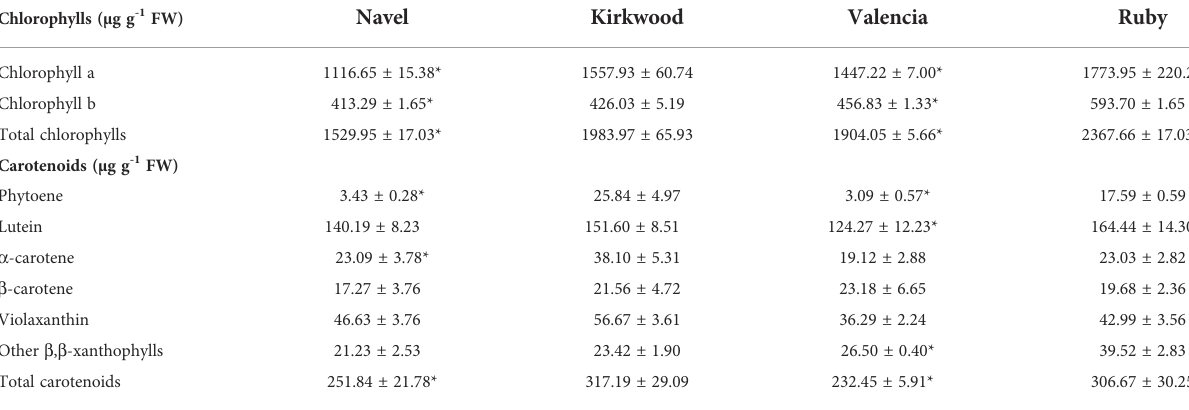
TABLE 3 Chlorophylls and carotenoids content and composition (µg g -1 FW) in leaves of Navel, Kirkwood Navel, Valencia and Ruby varieties.